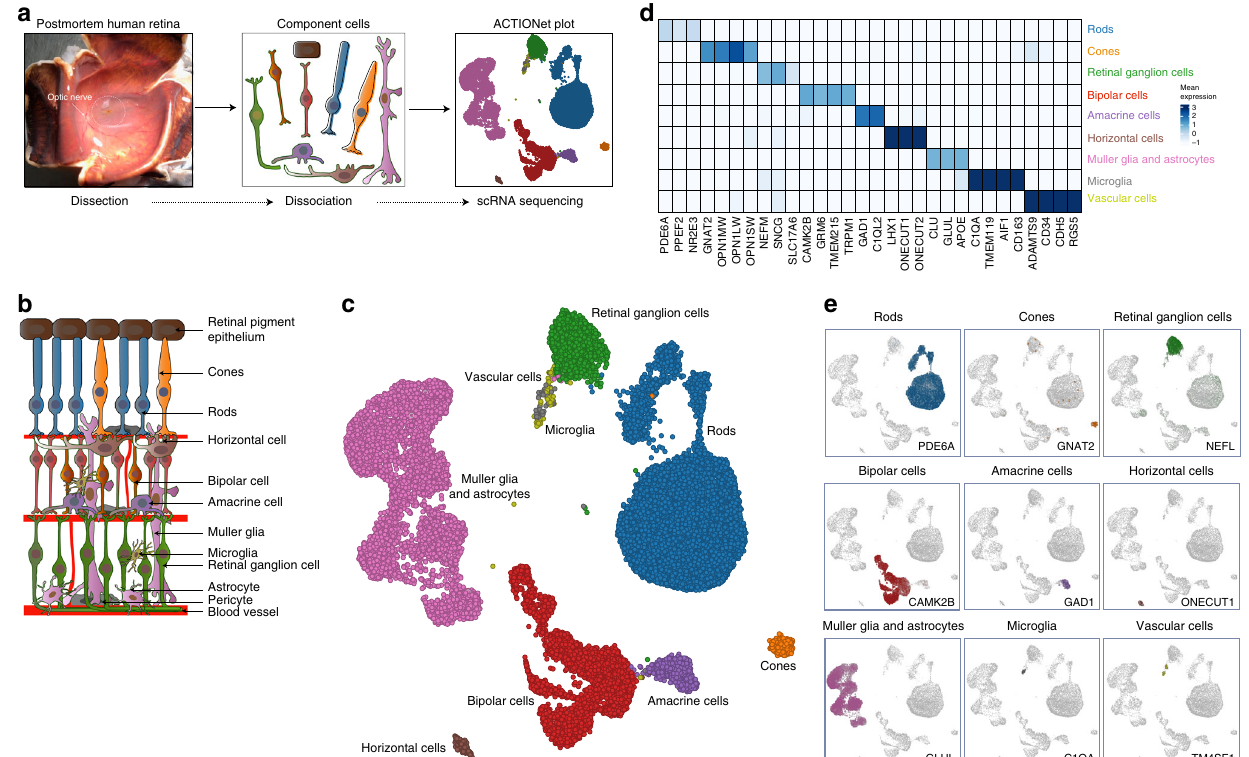
Fig. 1 Single-cell transcriptomic analysis reveals human retina diversity. a Study design and sample preparation. Postmortem human retinas were enzymatically dissociated and single-cells were isolated. cDNA single-cell libraries were generated and sequenced. We pro fi led 20,091 cells across the retinas of three normal individuals using a droplet-based micro fl uidics scRNA-seq platform. b Sketch of retina cross-section showing layers and major cell types. c Cell-to-cell similarity network of retinal cells. d Average expression of known cell-type marker genes across cell groups. e Projection of known cell- type-speci fi c marker gene expression across cell groups. d , e show localization of distinct cell types within the network, identifying neighborhoods of rods, cones, retinal ganglion cells, bipolar cells, amacrine cells, horizontal cells, macroglia (Müller glia and astrocytes), microglia, and vascular